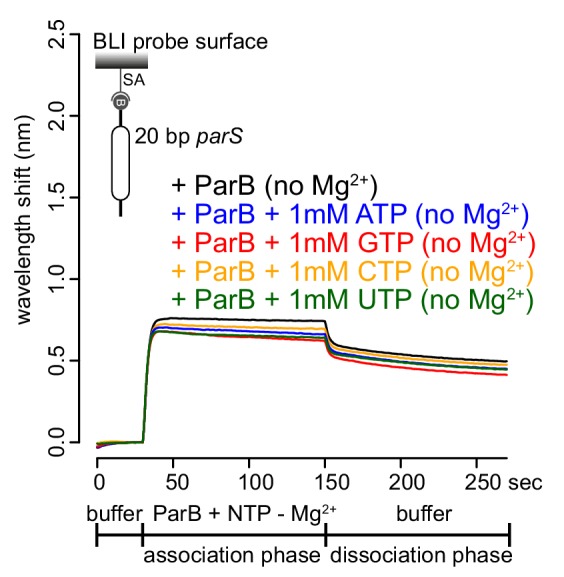
BLI analysis of the interaction between purified Caulobacter ParB and NTP in buffers lacking Mg2+.Caulobacter ParB-His6 (1 µM dimer)±1 mM NTP, and a 20 bp DNA duplex containing parS were used. Mg2+ was omitted from all buffers in this experiment. A schematic of the DNA substrate is shown above the sensorgram.Figure 1—figure supplement 2—source data 1.Data used to generate Figure 1—figure supplement 2.